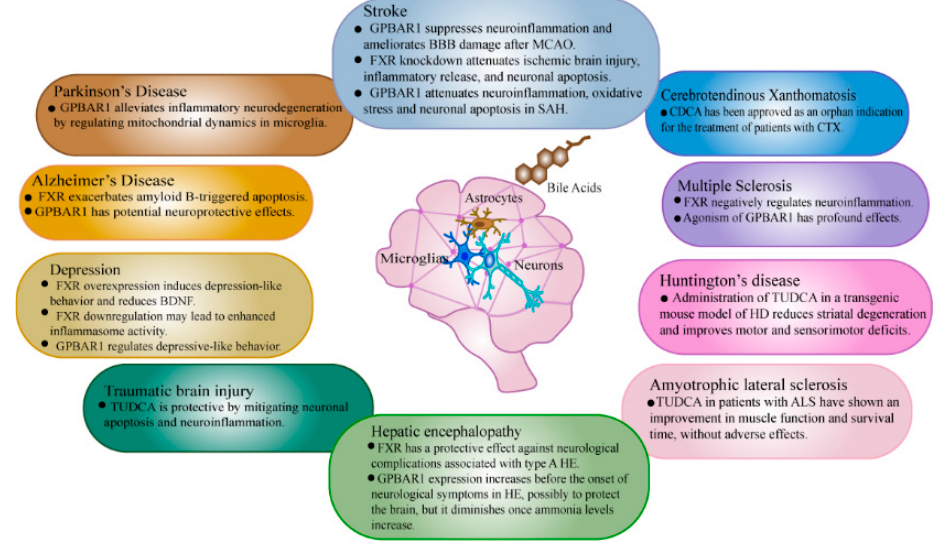
Figure 2. Summary of the effects of bile acid-mediated signaling on brain disease.